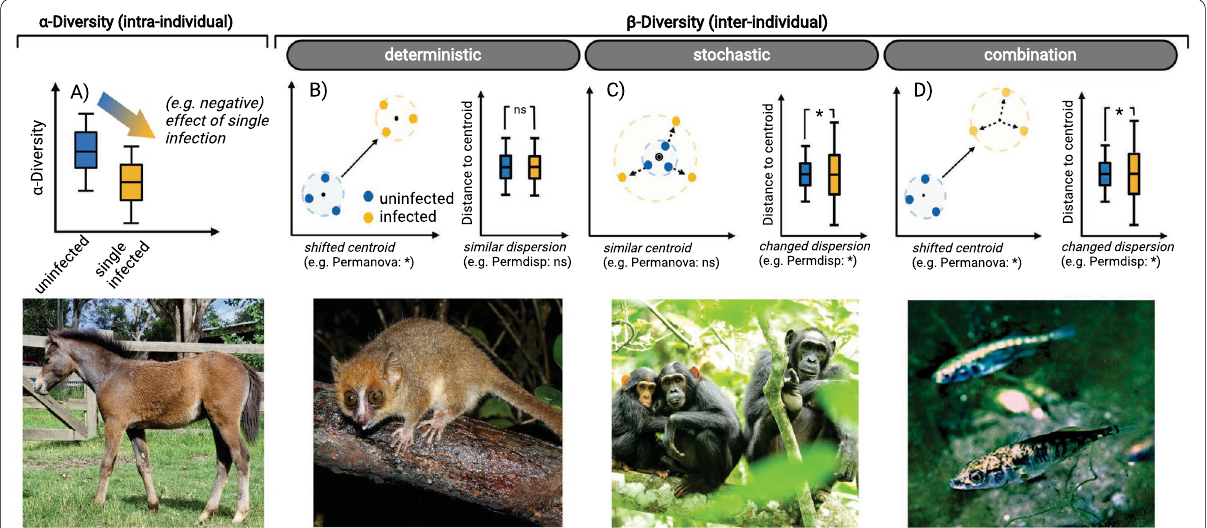
Fig. 1 The impact of single infections on α- and ß-diversity of the host’s microbiome with examples. A Single infections can have a directional effect on microbial species diversity. Equine gut microbial α-diversity, for instance, decreased following helminth infection [17]. B Single infections may result in deterministic changes to the microbial community composition (i.e., ß-diversity), which are characterized by a shift of the centroid ( black dot; e.g., analysed by Permutational Multivariate Analysis of Variance, Permanova). In this case, the dispersion stays similar (e.g. analysed by = Permutational Analysis of Multivariate Dispersions, Permdisp). For example, the gut microbial composition shifted in Adenovirus-infected mouse lemurs [11]. C Alternatively, single infections may lead to a changed dispersion, which can be visualized as distance to centroid (spread arrow). An example are chimpanzees infected by the simian immunodeficiency virus, which had a more dispersed gut microbiome [21]. D Single infections can also lead to both stochastic and deterministic effects. Three-spined stickleback ( Gasterosteus aculeatus ), for instance, infected with the cestode Schistocephalus solidus had a more dispersed and shifted gut microbial community [22]. * ns non-significant differences (i.e., p -value > =